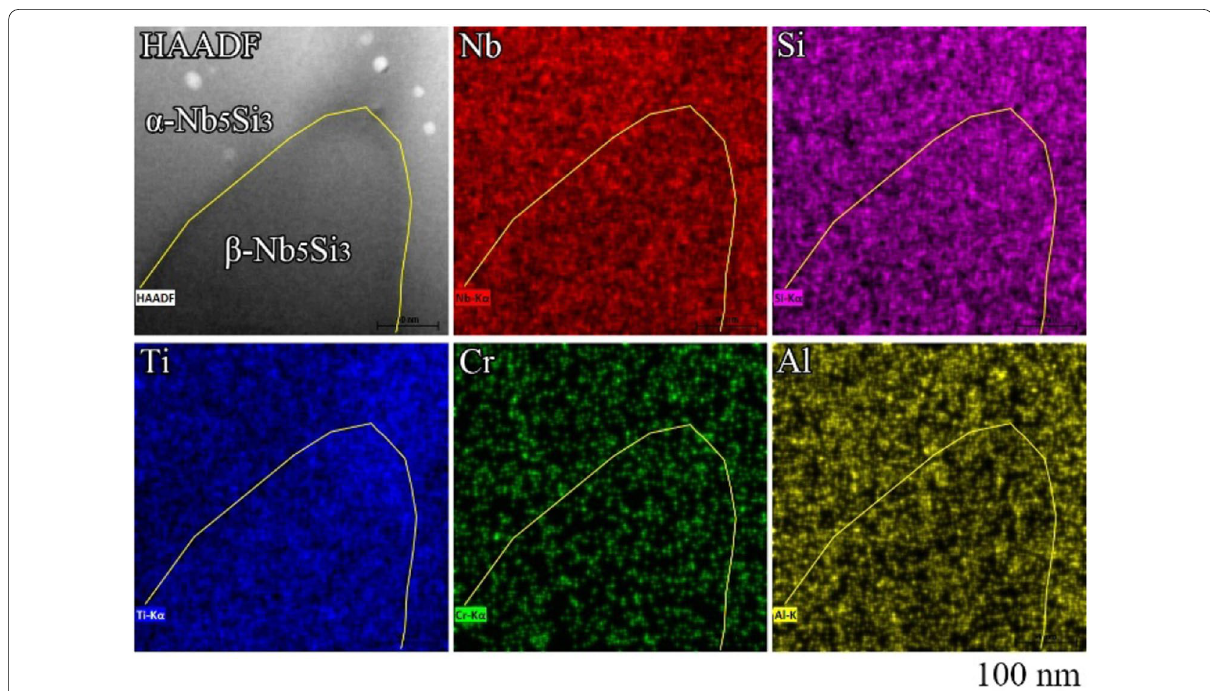
Figure 7 STEM-EDS mapping of the selected region for the hypereutectic Nb-Si based alloy via EBSM after annealing treatment at 1450 °C for 5 h, showing the distributions of Nb, Si, Ti, Cr and Al